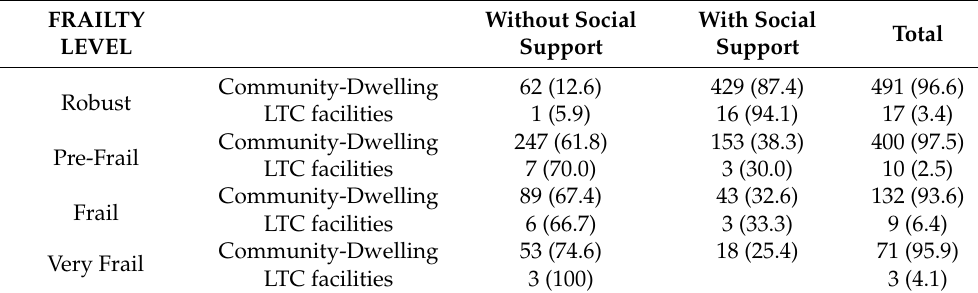
Table 3. The absolute number of LTC access stratifies for frailty level and social support.